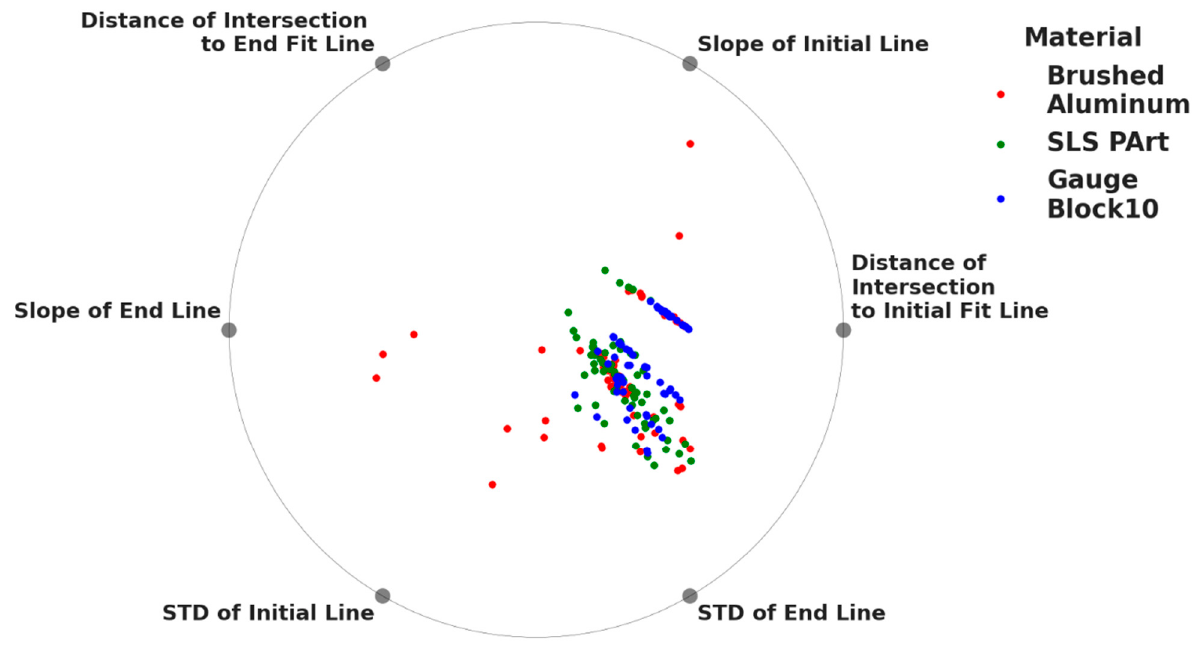
Figure 13. RadViz of parameters for each test, separated by material.